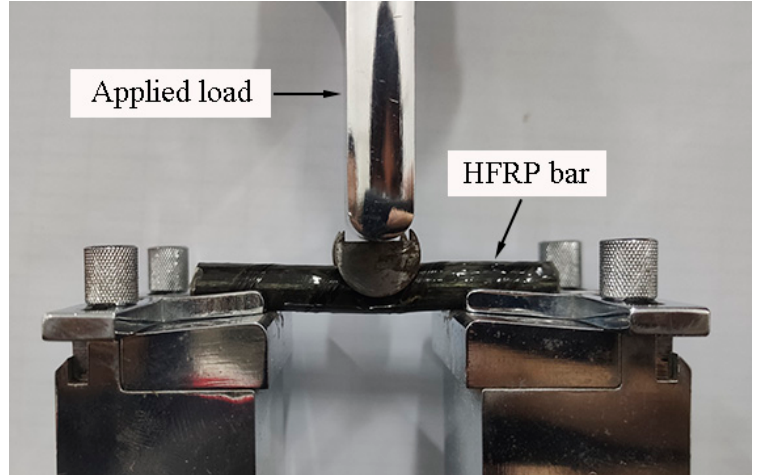
Figure 4. The image of short beam shear test setup.